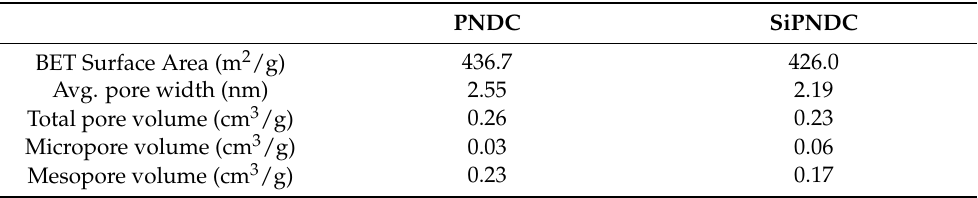
Table 2. Surface area and porosity analysis of doped carbon materials.